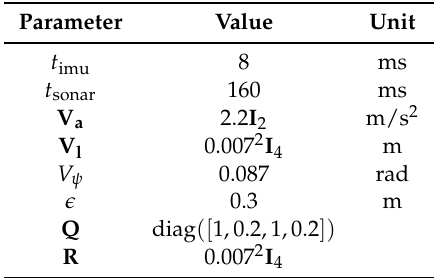
Table 5. Simulation